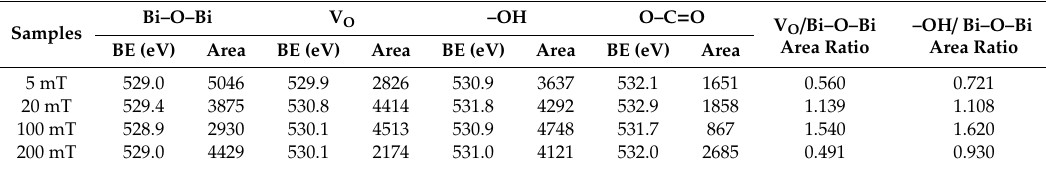
Figure 17. High ‐ resolution XPS spectra of Bi 4f for Bi 2 O 3 :Ho 3+ thin films deposited at different O 2 partial pressures (T S = 400 °C): ( a ) 5 mT, ( b ) 20 mT ( c ) 100 mT and ( d ) 200 mT. Table 7. O 1s peak positions and peak areas of the Bi 2 O 3 :Ho 3 + thin films deposited at di ff erent O 2 partial pressures (T S = 400 ◦